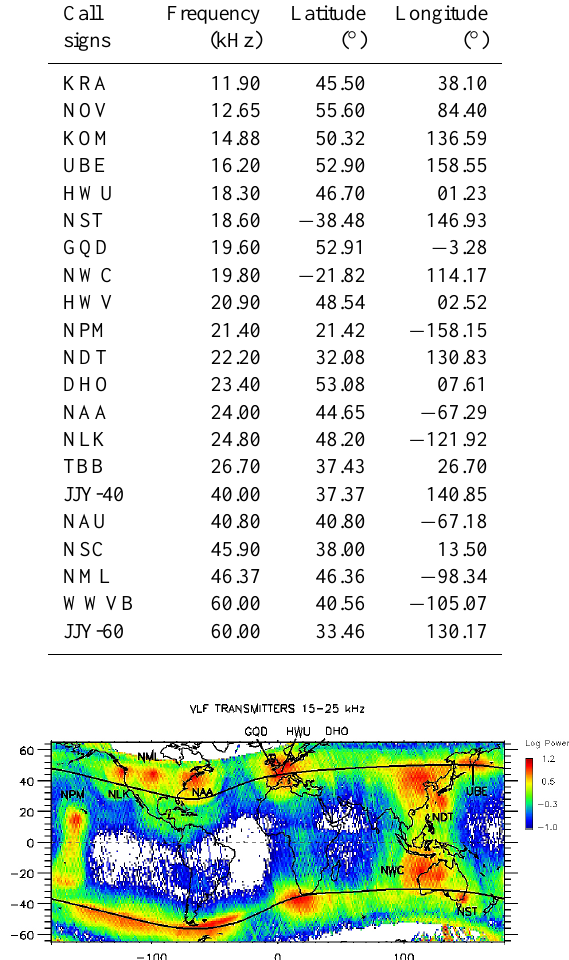
Table 1. Locations of the VLF transmitters displayed in Figs. 6, 7 and 8.